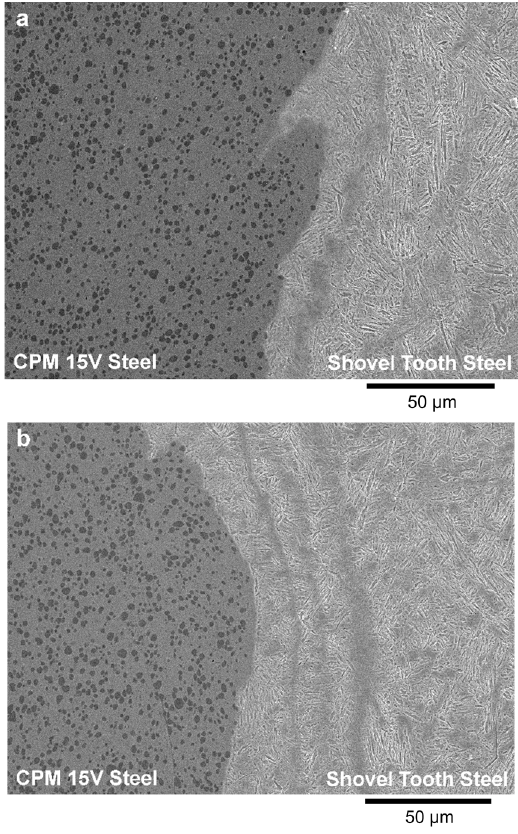
Figure 9. Representative microstructures at the interface for the HF condition observed by SEM, where ( a ) and ( b ) are different regions at the